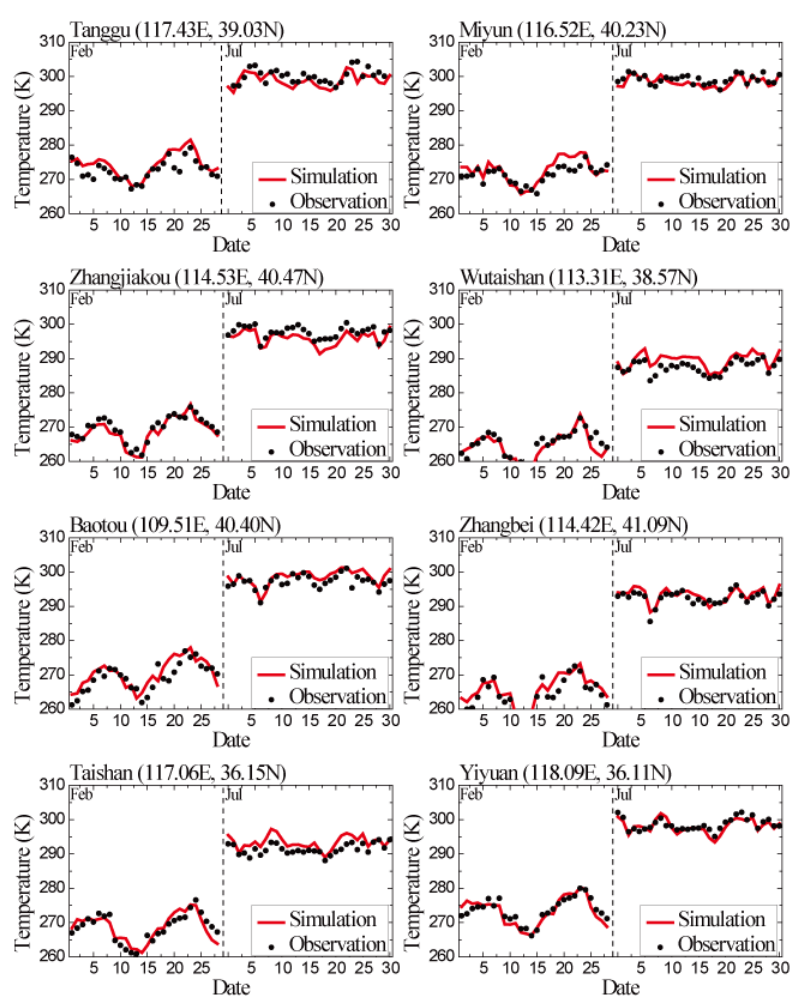
Figure 2. Observed (black circles) and modeled (solid red lines) daily-average temperatures (K) at eight stations in February and July 2011.